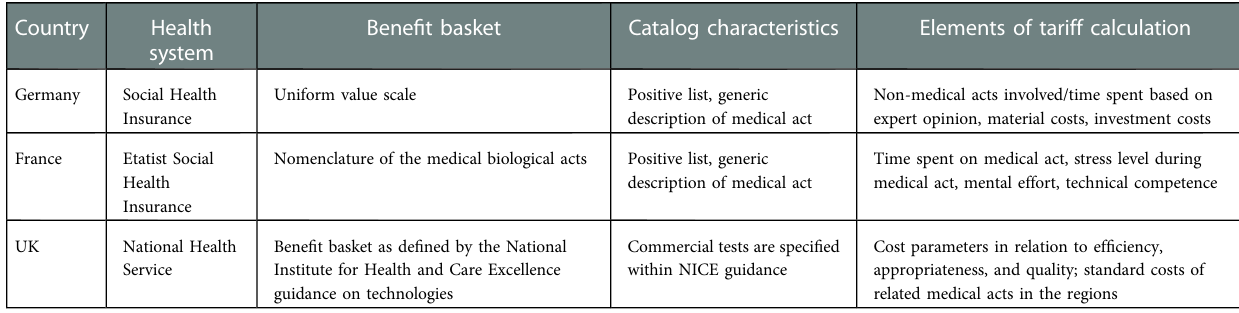
TABLE 6 Reimbursement solutions for IVDs in selected European